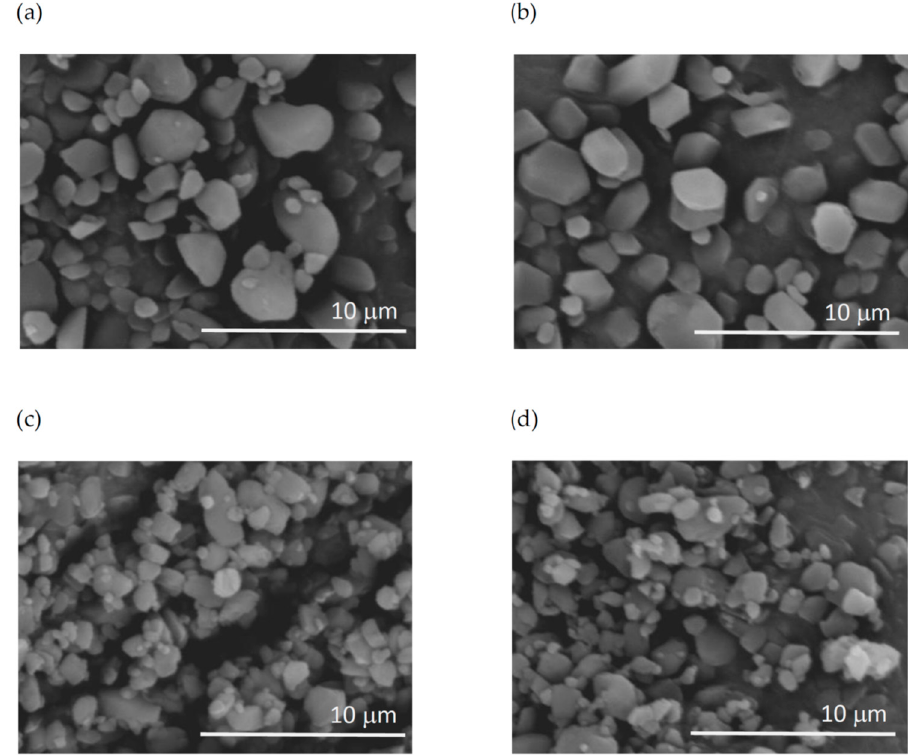
Figure 6. SEM pictures of BUD particles in the suspensions ( a – d ) (magnification × 10,000).